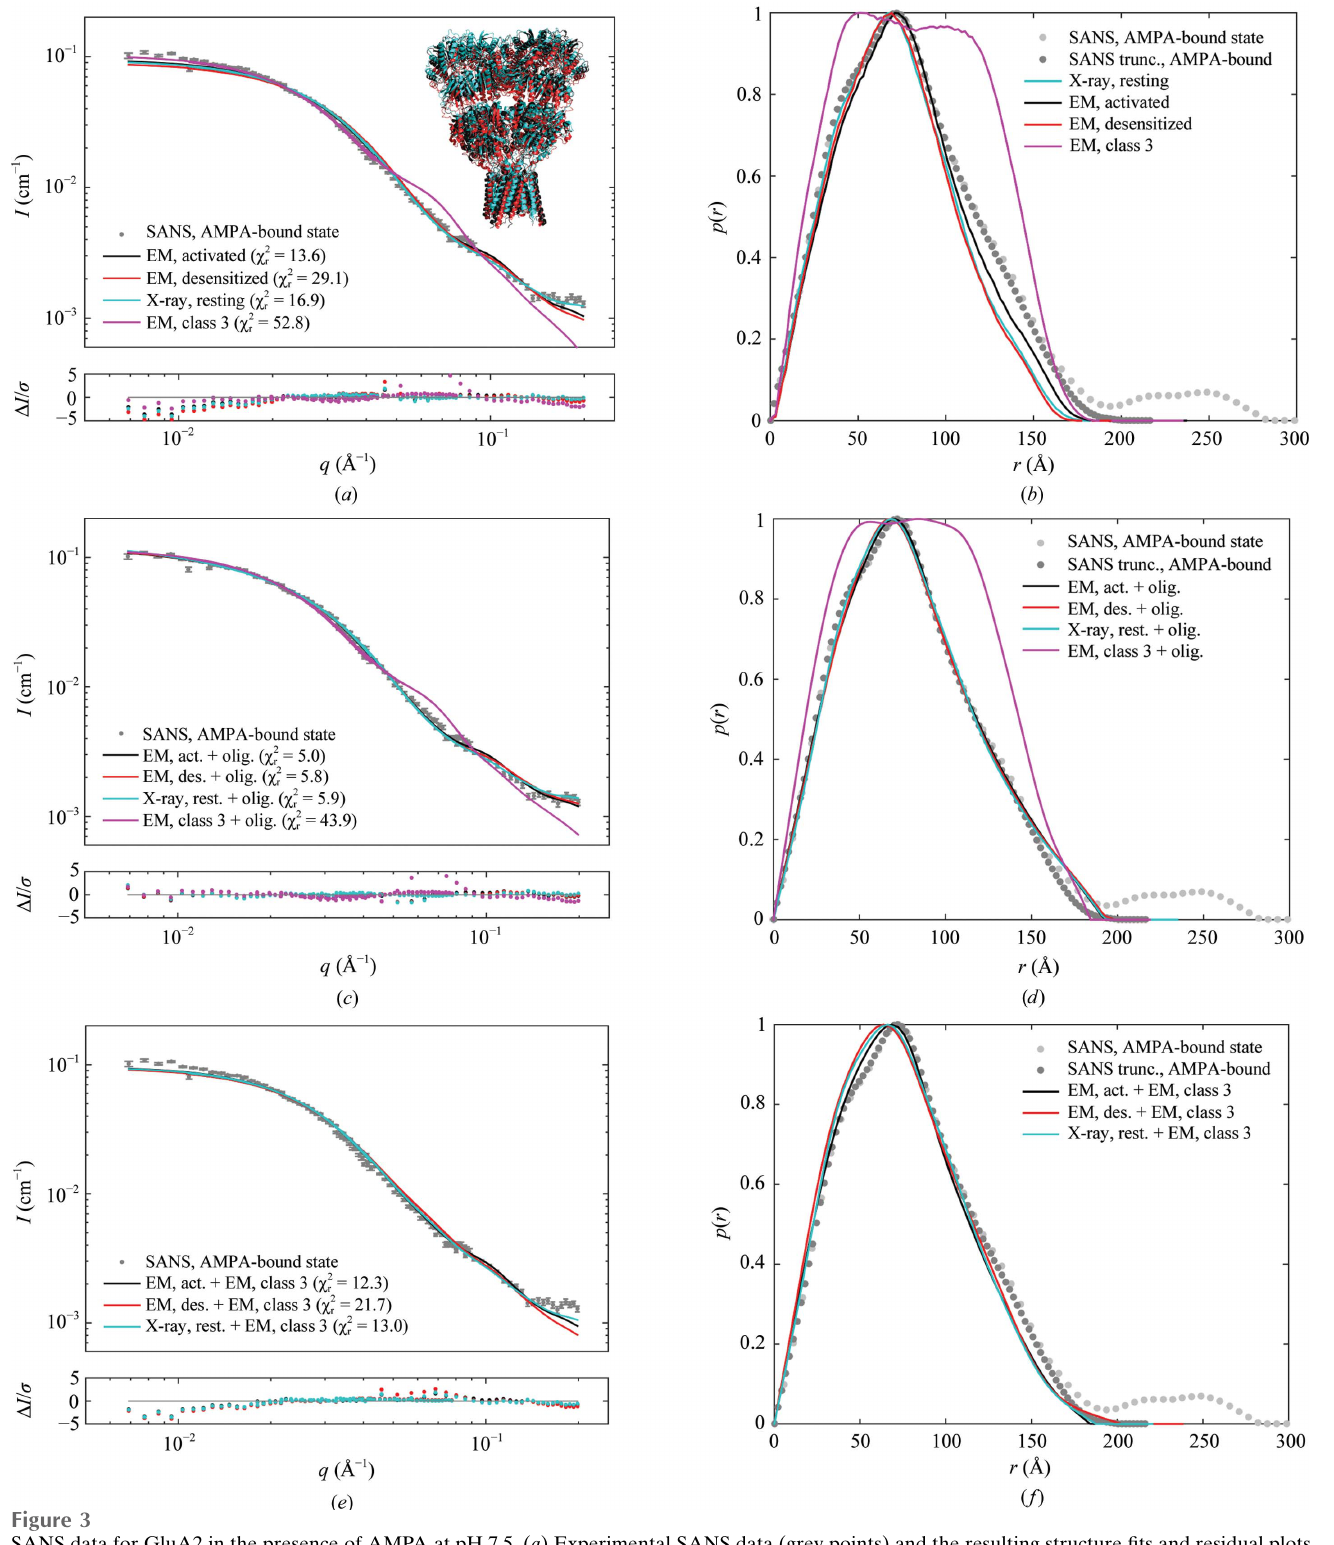
Figure 3 SANS data for GluA2 in the presence of AMPA at pH 7.5. ( a ) Experimental SANS data (grey points) and the resulting structure fits and residual plots for the crystal structure of GluA2 in the resting state (PDB entry 4u2p; cyan; Du¨rr et al. , 2014), GluA2 in the activated state (PDB entry 5weo; black; Twomey et al. , 2017 b ), GluA2 in the desensitized state (PDB entry 5vhz; red; Twomey et al. , 2017 a ) and GluA2 in the class 3 EM structure (EMD-2688; magenta; Meyerson et al. , 2014). A cartoon representation of the three structures overlaid is shown in the respective colours. ( b ) p ( r ) functions for the SANS data (light grey points) and for a truncated data set ( q (cid:9) 0.011 A˚ (cid:5) 1 ; dark grey points) with the p ( r ) for four structures. ( c , d ) Resulting fits and p ( r ) functions for linear combinations of the atomic structures and fractal oligomers. ( e , f ) Resulting fits and p ( r ) functions for combinations of the atomic structures and the class 3 EM